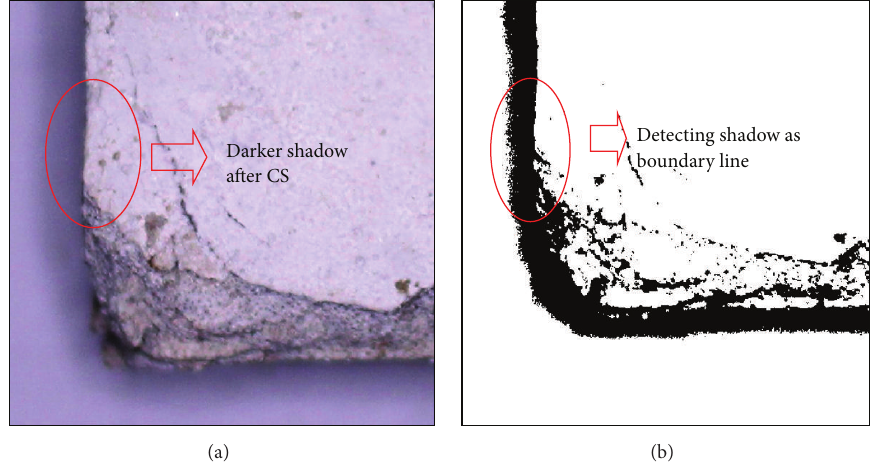
Figure 5: Problems related to shadow.